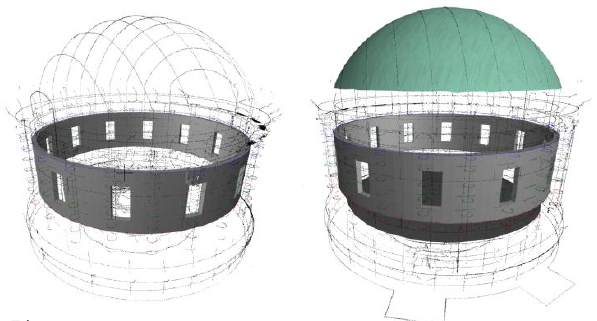
Figure 11. Wall containing deformation automatically generated from cut sections. Additional mesh surfaces used to represent dome roof and floor surfaces (right).